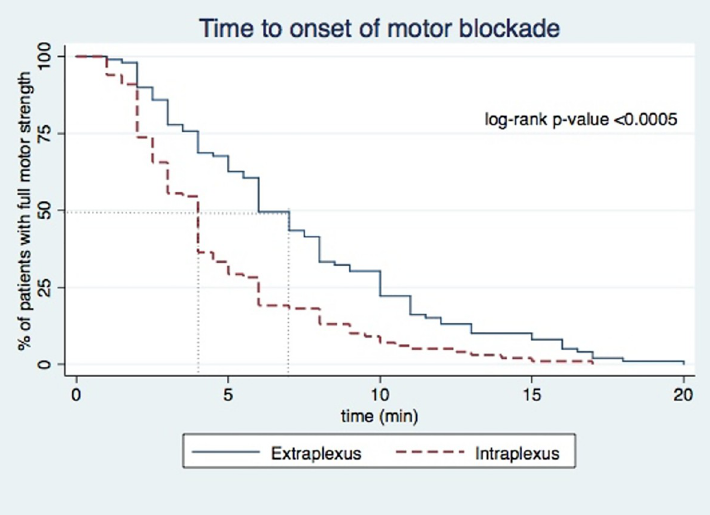
Fig 2. Kaplan-Meier curve of time to onset of motor blockade. Extraplexus (solid line); intraplexus (dashed line).